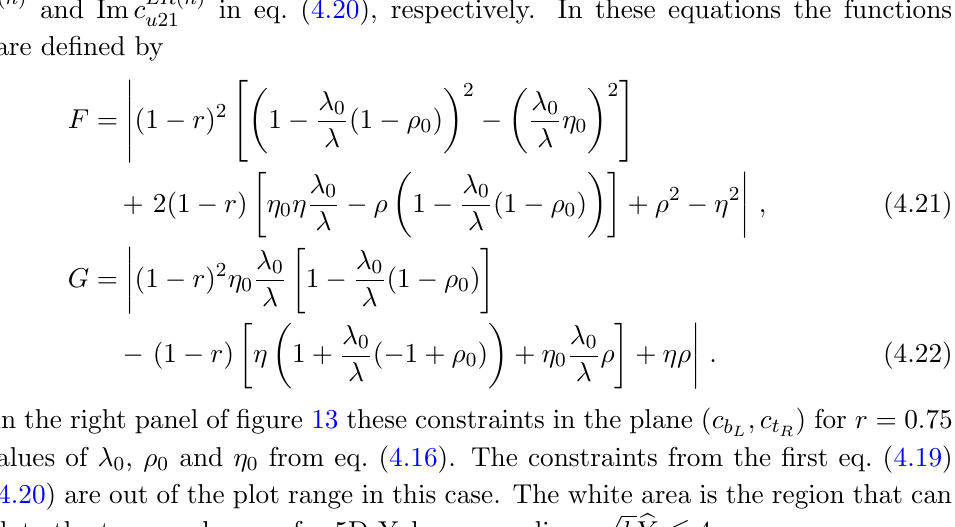
Figure 13 . Left panel: region in the plane ( c b down-type quarks, eqs. (4.12){(4.15), and the value of the bottom quark mass for p k b Y b < 4. Green region represents the excluded regime from the constraint (4.15). Right panel: region in the plane ( c b ; c t ) compatible with the (cid:13)avor constraints for up-type quarks, eqs. (4.19){(4.20), and top L R quark mass for p k b Y t < 4. Red region represents the excluded regime from the constraint of the second equation in